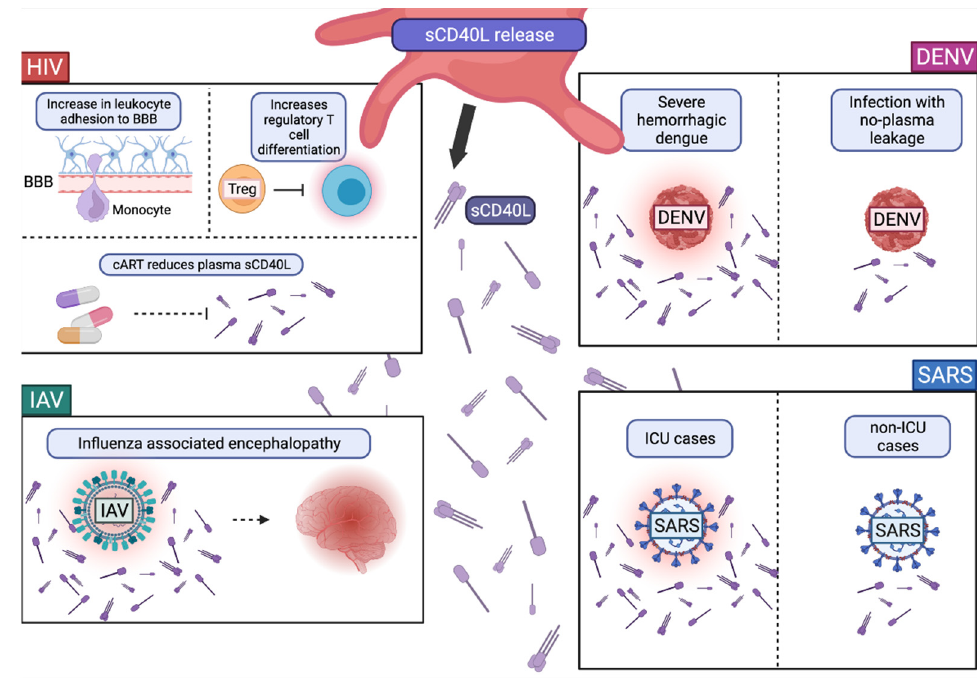
Figure 2. Role of sCD40L in Viral Infections. One major source of sCD40L in human plasma is platelets. In human immunodeficiency virus (HIV) infection, sCD40L increases leukocyte adhesion to the blood brain barrier (BBB), perhaps leading to extravasation and increases in regulatory T cell differentiation, which potentially leads to a reduction in T-cell responses. The administration of combination anti-retroviral therapy (cART) reduces plasma sCD40L levels. In dengue virus (DENV) infection, high levels of plasma sCD40L is associated with severe hemorrhagic dengue with plasma leakage. In influenza A virus (IAV), a high plasma sCD40L level is associated with severe disease and influenza-associated encephalopathy. In SARS-CoV-2 infection, high levels of plasma sCD40L was found in intensive care unit (ICU) cases compared to lower plasma sCD40L levels found in non-ICU cases. Created with BioRender.com (9 February 2022).